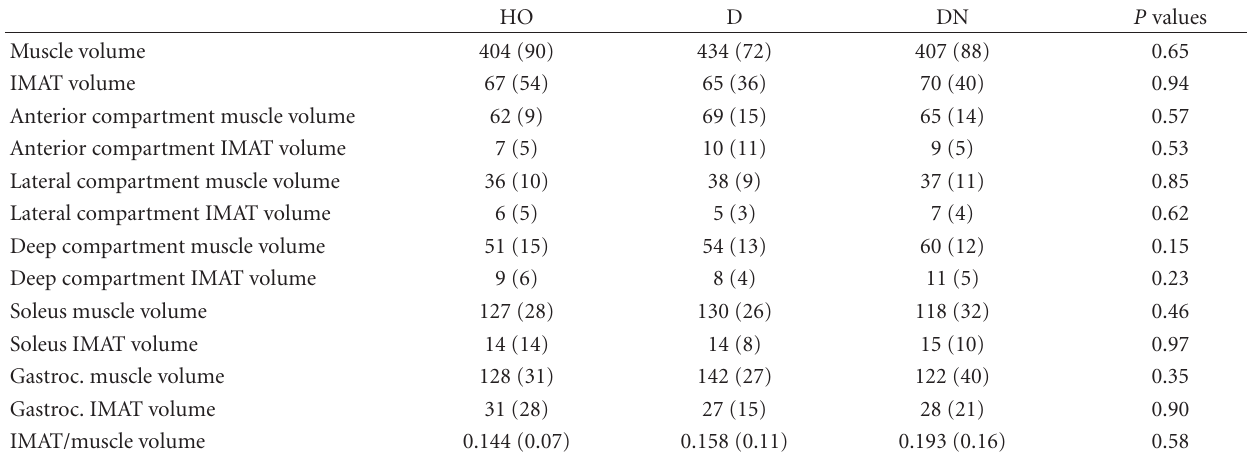
Table 2: ANOVA results: muscle morphology measures; all values are means (SD) in cm 3 . HO D DN P values Muscle volume